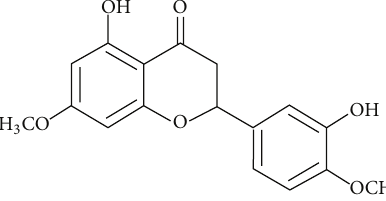
Figure 1: Chemical structure of 5,3 󸀠 -hydroxy-7,4 󸀠 -dimethoxyflavan- one isolated from fruits of Picramnia gracilis